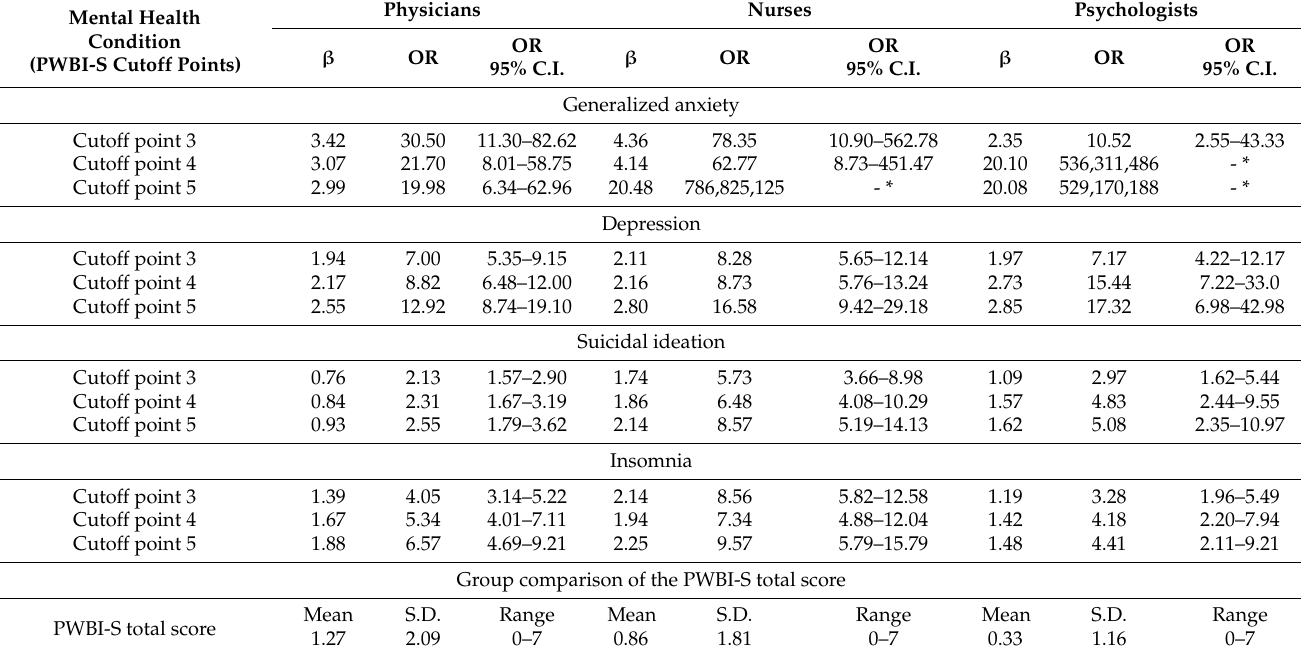
Table 3. Univariate logistic regression for mental health conditions using the Spanish version of the Physician Well-Being Index (PWBI-S) to determine the risk for the development of adverse mental health outcomes and comparison of the mean PWBI-S scores among